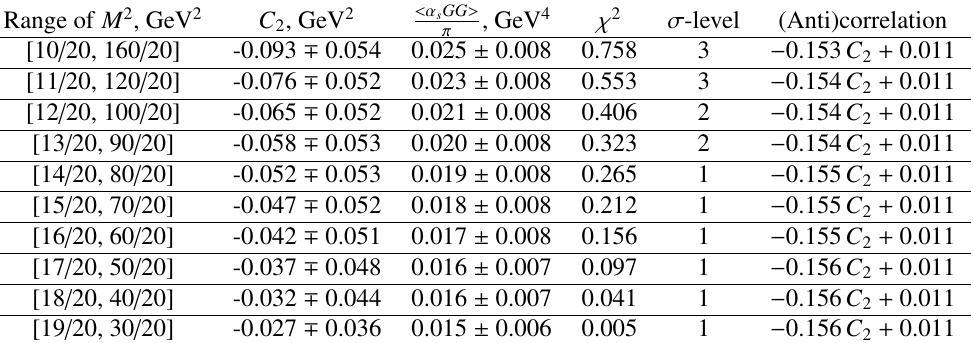
Table 3. The fitting results for di ff erent intervals of M 2 in PT with Λ = 0 . 25 GeV. In the fifth column the σ -level where C 2 = 0 is shown. In the sixth column the (anti)correlation between the gluon condensate and C 2 is